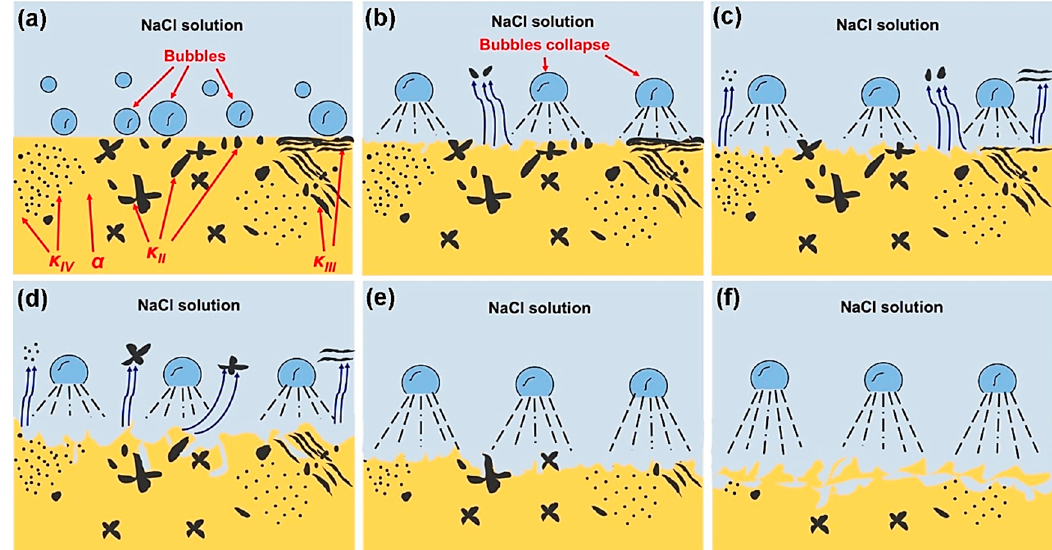
Figure 11. Corrosion mechanism diagram of NAB with different CE times: ( a ) CE bubbles appear on the surface of NAB with a complex phase structure; ( b ) the bubbles destroy the α phase and the small-sized κ II phase peels off; ( c ) bubbles further destroy the boundary of the α / κ phase, causing the peeling of κ II , κ III and κ IV ; ( d ) the surface of the α phase is damaged by the bubbles, and the large-sized κ II phase peels off; ( e ) the internal κ phases are exposed to the surface again; ( f ) the internal κ phases peel off again caused by the destruction of bubbles.